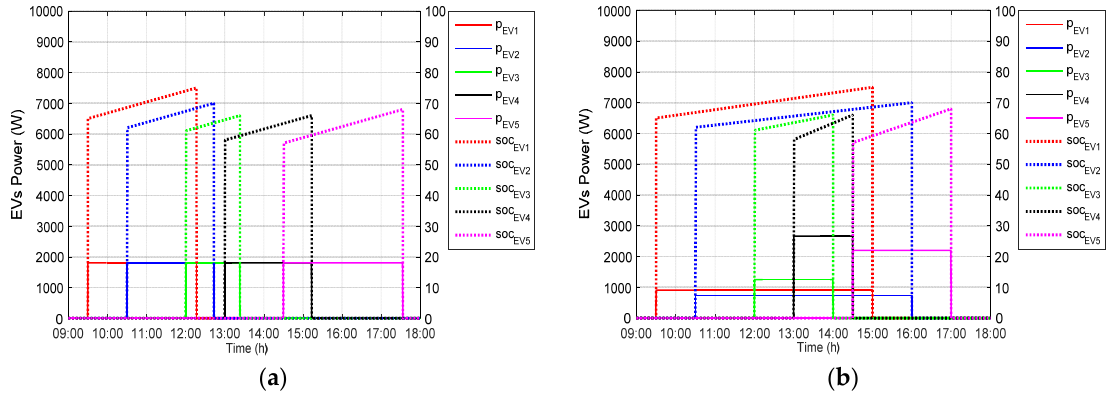
Figure 17. ( a ) EVs charging power and EVs SOC evolution for Scenario 2a; ( b ) EVs charging power and EVs SOC evolution